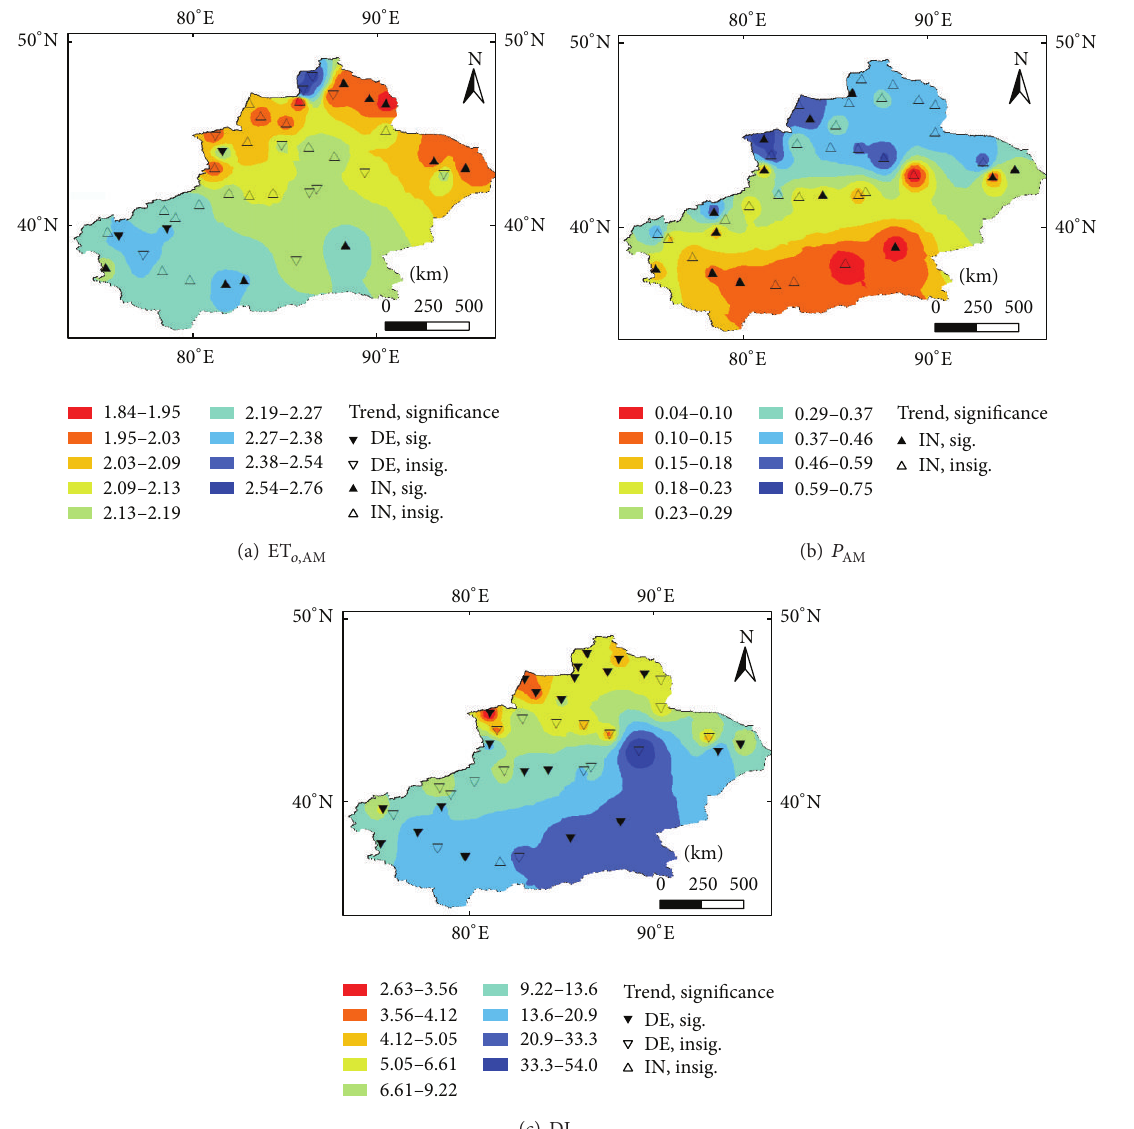
Figure 3: Spatial distributions and trends of ET 𝑜, at a 95% confidence level, insig.: insignificant at a 95% confidence level (similar